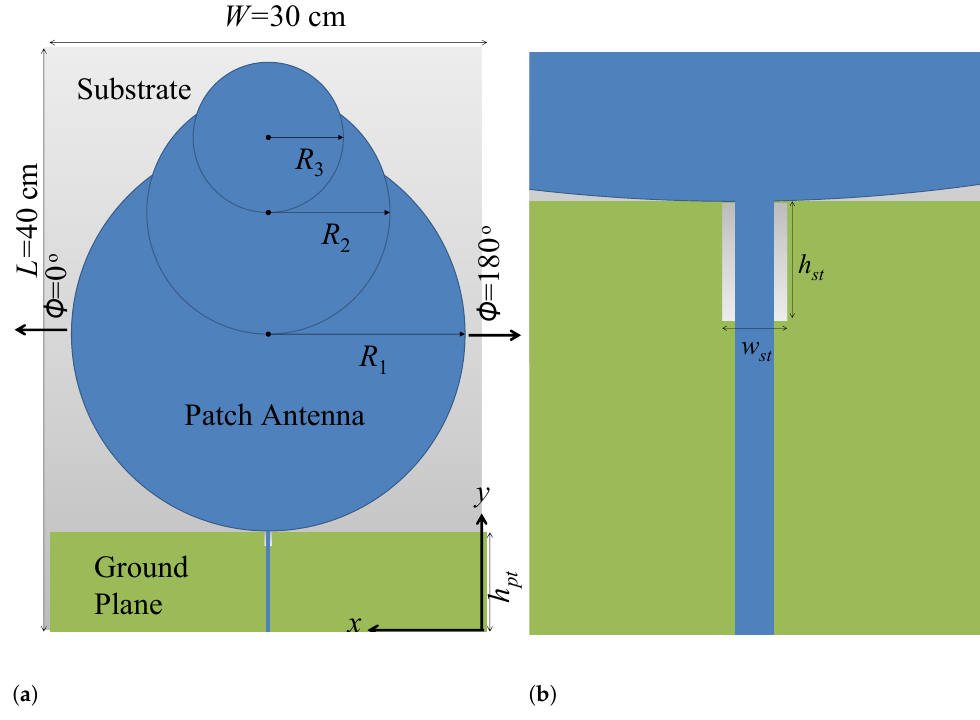
Figure 11. Preliminary antenna model simulated using COMSOL Multiphysics: ( a ) overview and ( b ) details of the ground plane slot (the ground plane and patch are on opposite sides of the